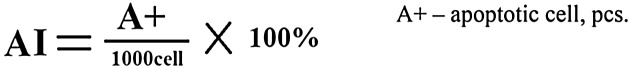
Apoptosis index formula.